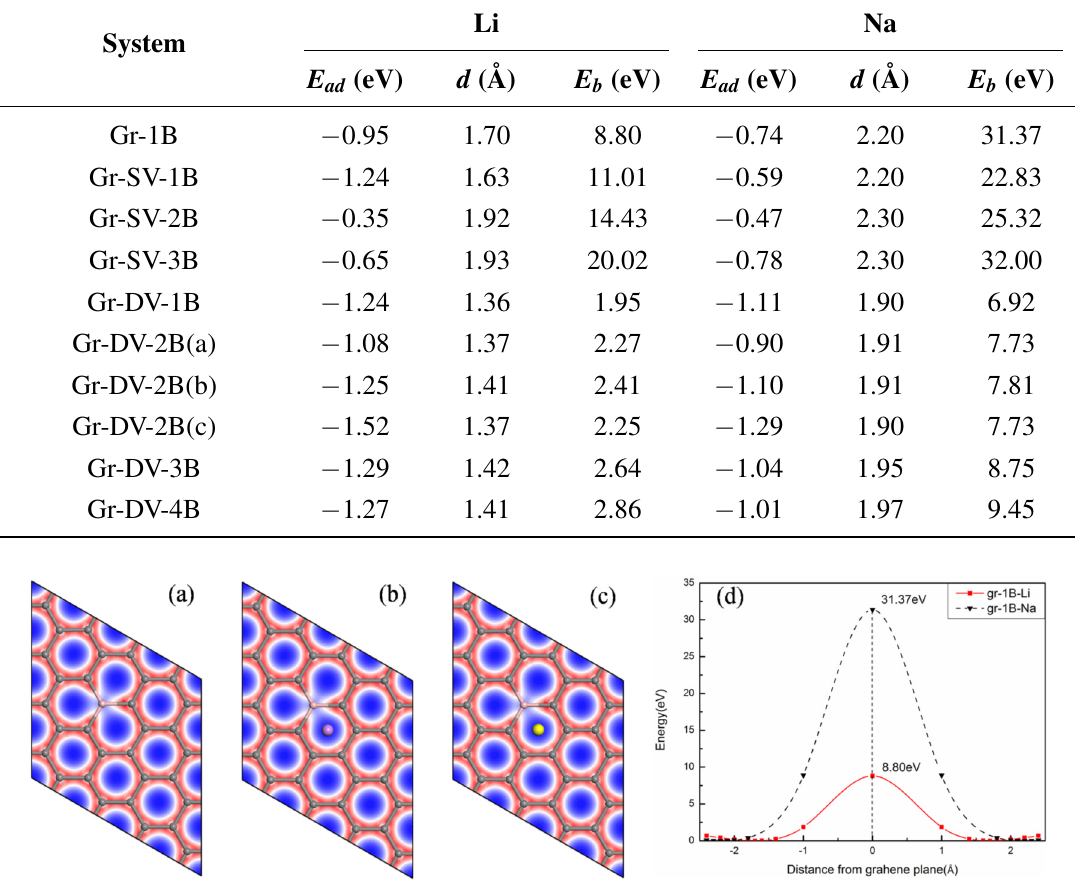
Table 3. Adsorption energy ( E ad ) of ions, distance of ions from the graphene sheet ( d ) and diffusion barrier ( E b ) for the B-doped systems investigated.